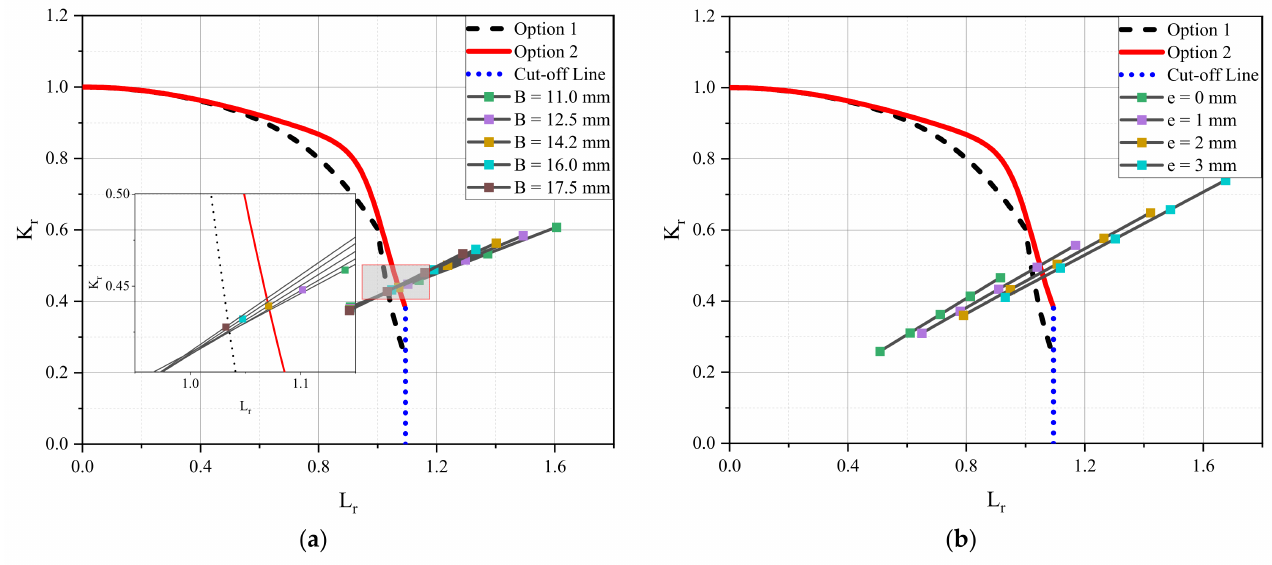
Figure 8. Effects of wall thickness and misalignment on the crack evaluation of pipe girth welds. ( a ) σ P = 0.9 σ Y ( b ) B = 11 mm.